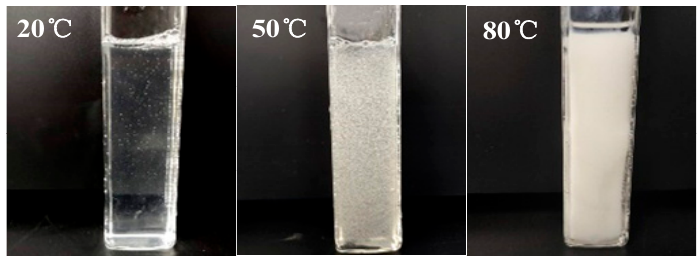
Figure 5. The phase change of thermosensitive hydrogels at different temperatures.